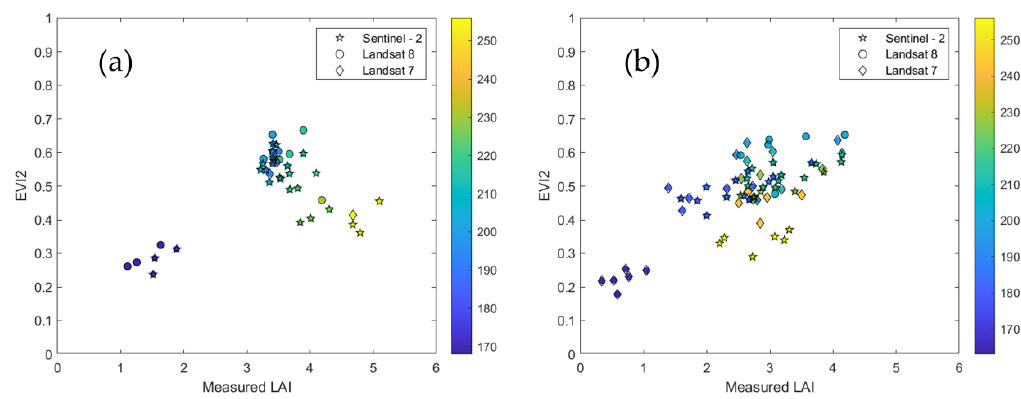
Figure 6. Relationship between field LAI measurements and EVI2 for 2018 ( a ) and 2019 ( b ). The color bar indicates observation dates (i.e., DOY, day of year).